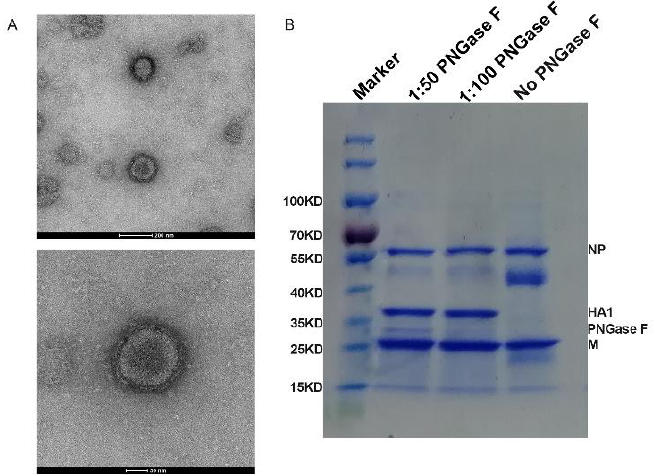
Figure 1. Characterization and identification of the inactivated whole-virus vaccine. ( A ) The electron micrograph of H5N8 inactivated whole viruses. ( B ) SDS-PAGE analysis of 3 µ g total protein in H5N8 virus vaccines with or without PNGase F treating (1:50 or 1:100 ratio). Purified HA protein of indicated amount was loaded to calibrate the HA content; the gel was stained with colloidal blue; images of SDS-PAGE were acquired by Bio-RAD software (ChemiDoc XRS+, 1708265). Each sample was tested in